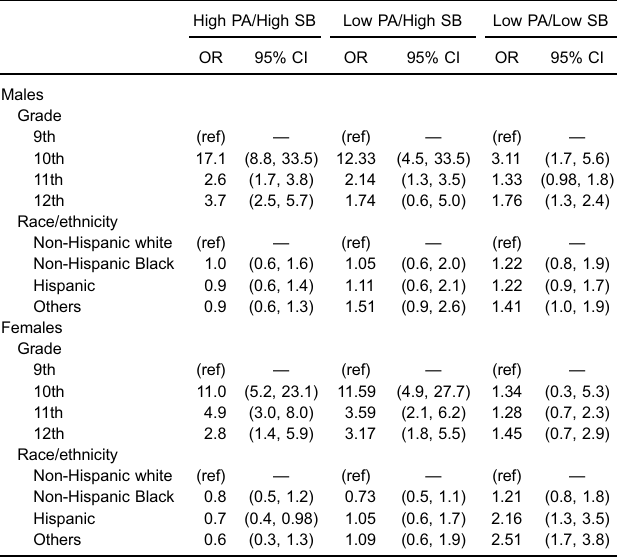
Table 5. Comparisons of the likelihood of being obese across the latent subgroups with different patterns of PA and screen-based